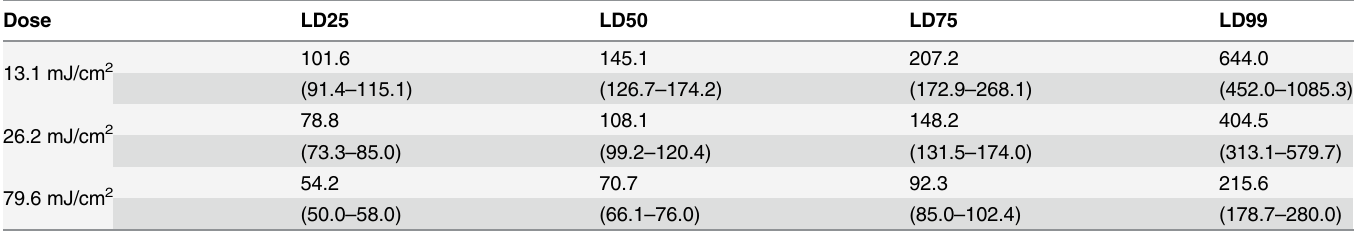
Table 1. Lethal Dosage Estimates. Point estimates and their associated 95% confidence intervals for HPE required to achieve lethal dosages (LD) for larvae population.